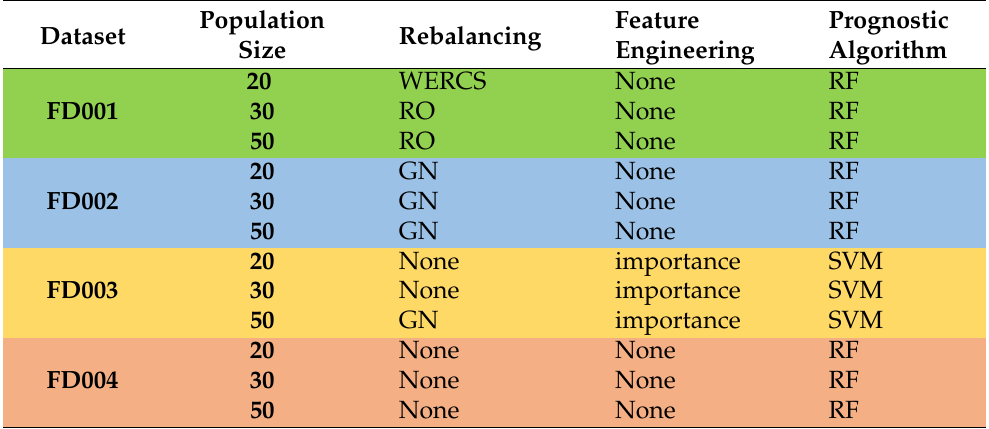
Table 13. The resulting prognostic settings when running the GPF with populations of 20, 30, and 50 individuals on the four C-MAPSS